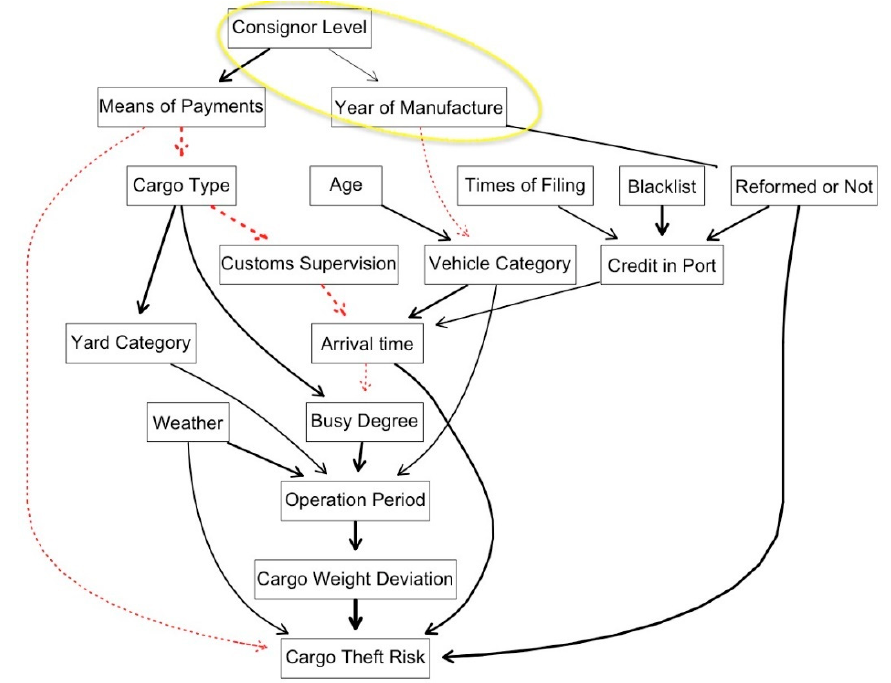
Figure A5. The Bayesian network structure derived using combinations of heuristic structure search algorithm with TABU and score function with Bic .